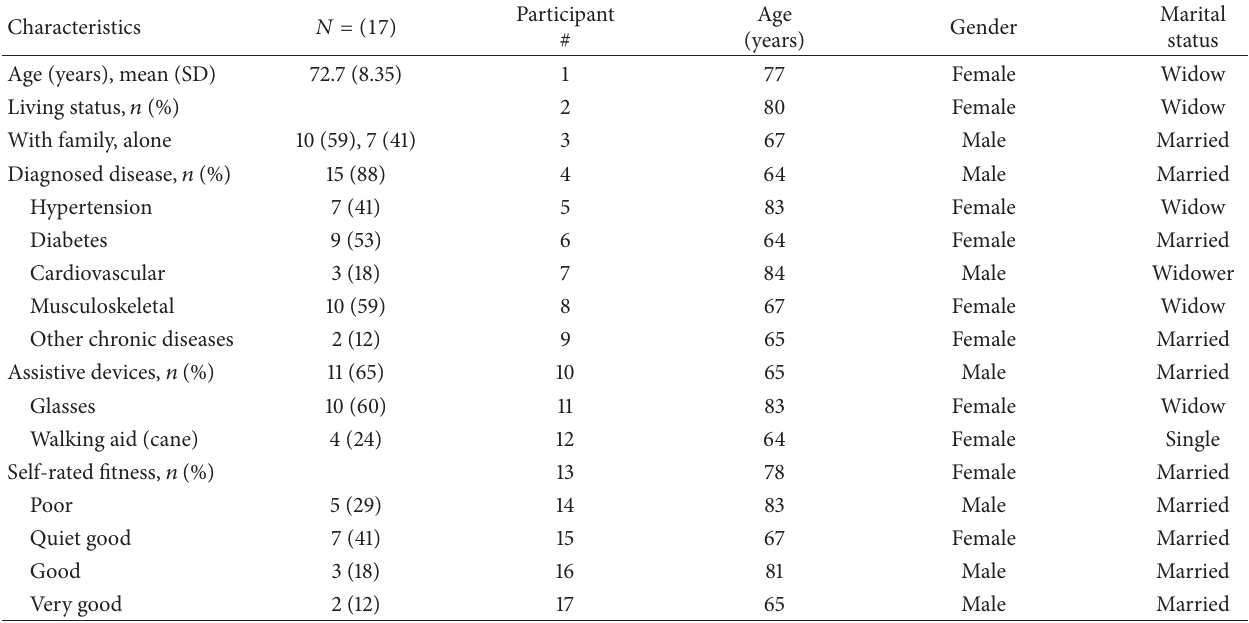
Table 1: Participants’ demographic and clinical